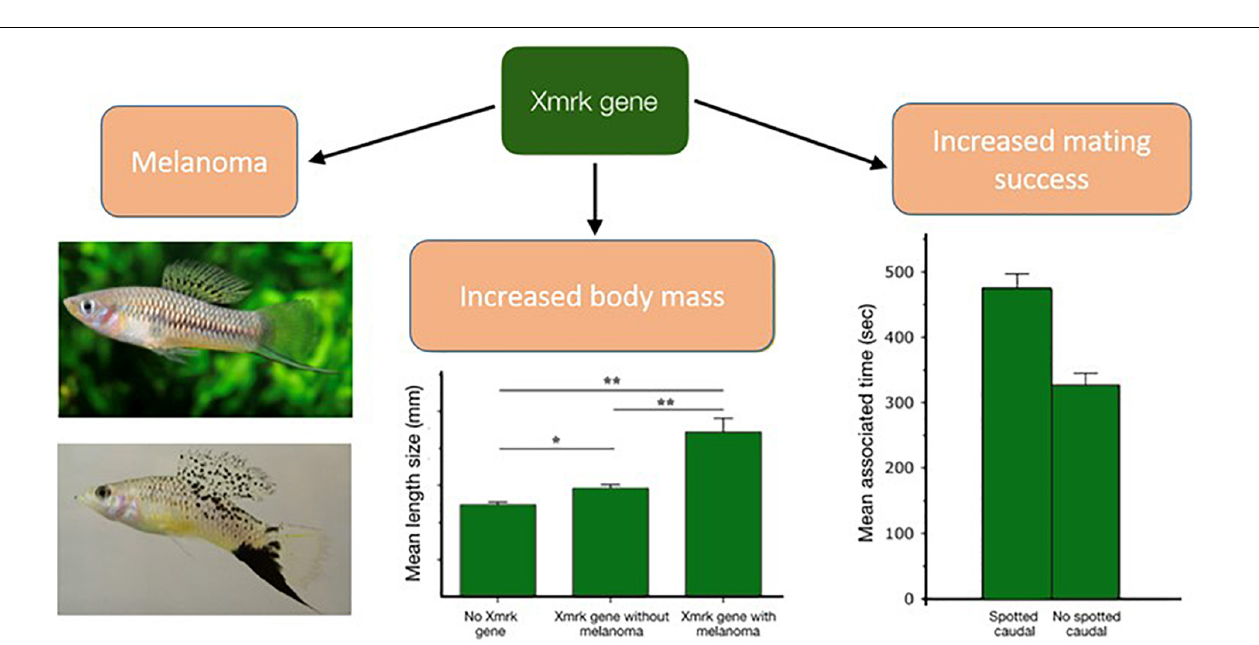
FIGURE 1 | Plan of this synthesis: malignant processes and then consequences on health and survival are linked in multiple ways with the age-specific reproductive activities of organisms.